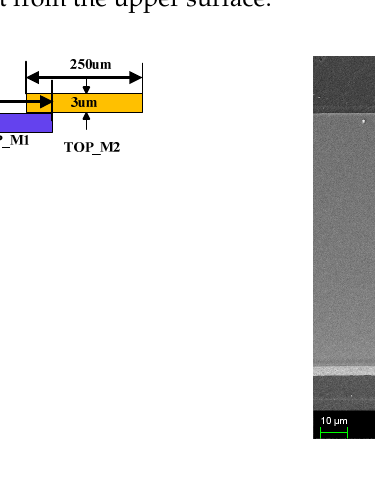
Figure 1. Vertical structure of TSV daisy chain unit: ( a ) schematic diagram; ( b ) SEM image. After running a thermal cycle experiment from − 55 °C to 125 °C on the sample for 1000 cycles, the DC resistance of three groups of TSV daisy chains was increasing significantly. The changes in DC resistance for thirteen groups of TSV daisy chains are shown in Table 1. Channel 6, with the largest resistance change, was selected for analysis. Table 1. Changes in DC resistance.